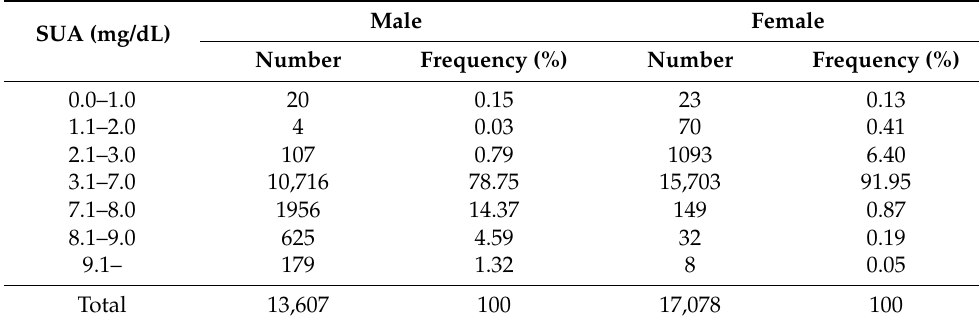
Table 1. Distribution of SUA levels of 30,685 Japanese health examination